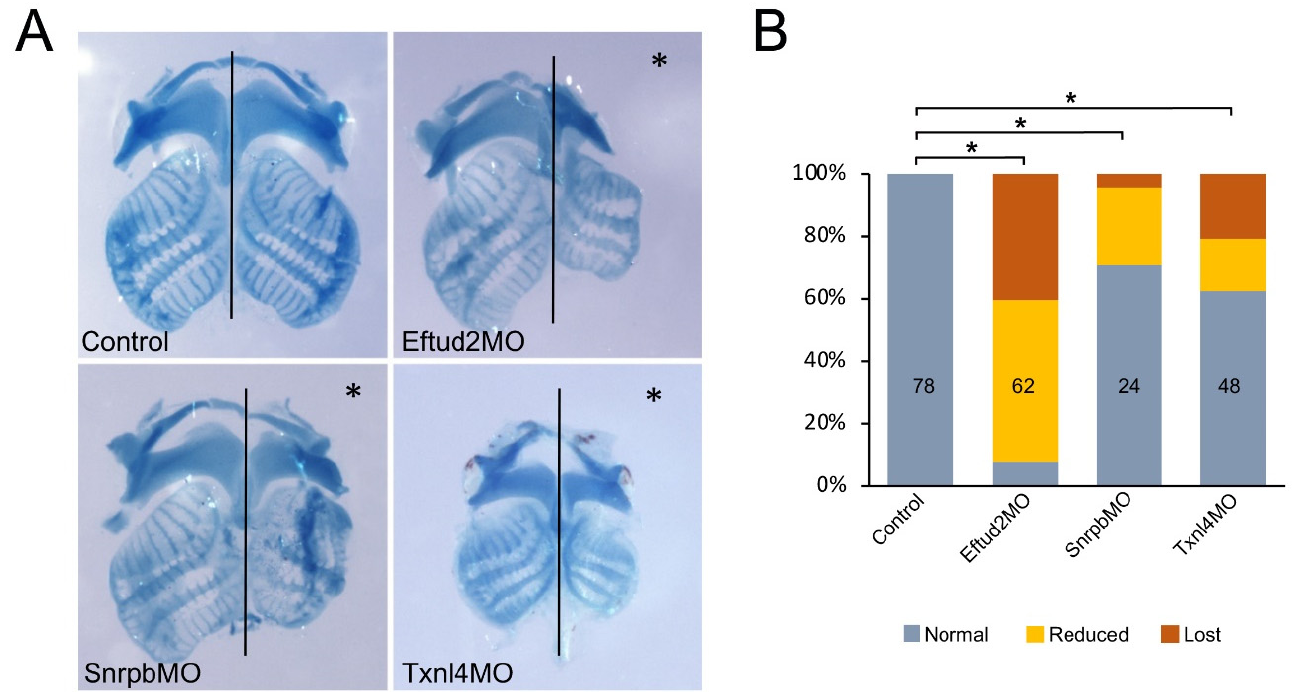
Figure 6. Eftud2, Snrpb and Txnl4a knockdown affect craniofacial cartilage formation. ( A ) Alcian blue staining of dissected craniofacial cartilages of control tadpoles and those injected with Eftud2MO (5 ng), SnrpbMO (1 ng) and Txnl4MO (30 ng), around stage 45. The injected side is indicted by an asterisk. The black lines indicate the midline. Note: Txnl4MO-injected tadpoles were collected at a slightly younger stage than their counterparts, which explains the overall size difference in craniofacial structures. ( B ) Quantification of the phenotypes. The numbers in each bar indicate the number of embryos analyzed. Control vs. MO-injected (*) p -value < 0.0001 (Chi-squared test).